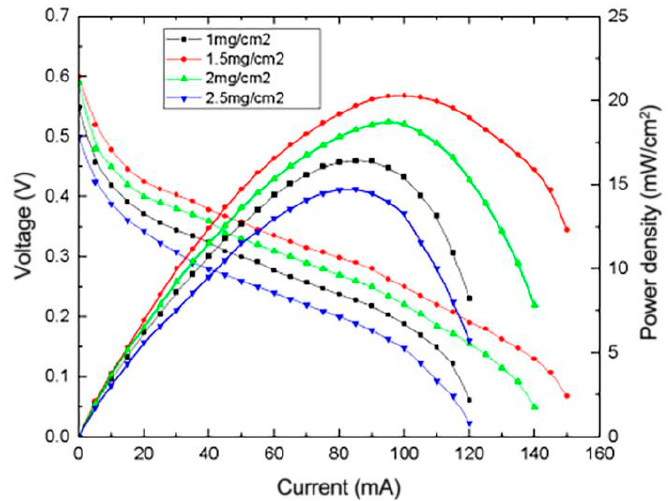
Figure 12. Effect of different carbon loading amounts on the performance of μ DMFC.